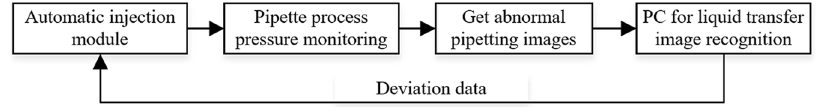
Figure 2. The closed-loop control flow chart of the microfluid-displacement detection